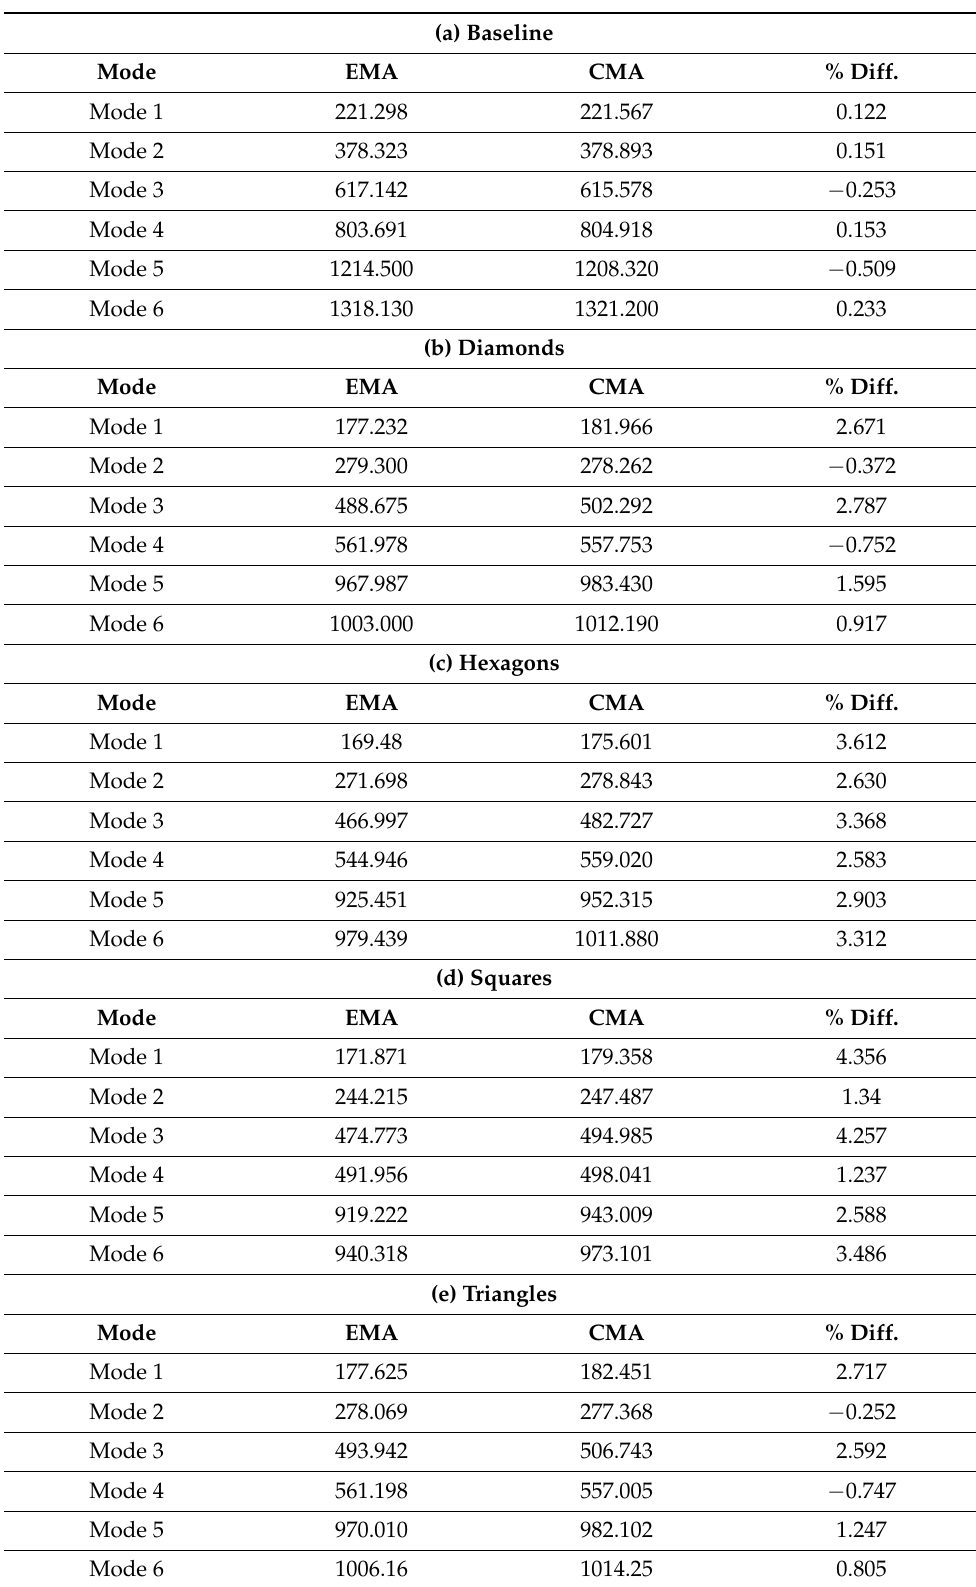
Table 1. EMA and CMA results for the first six modes for the considered